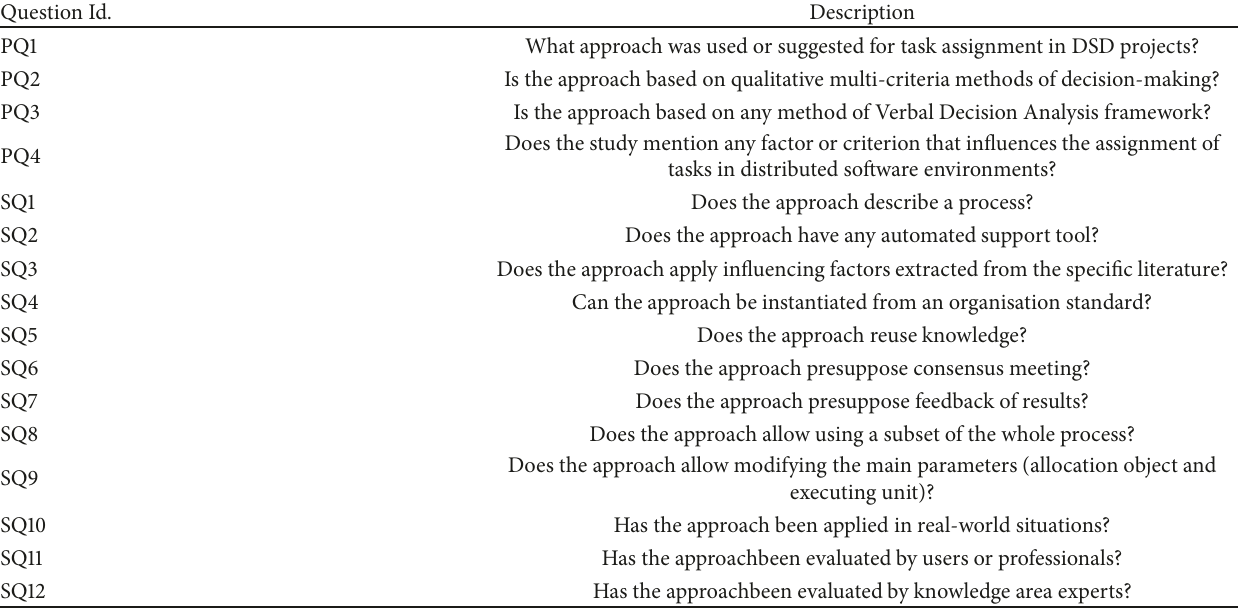
Table 1: Codes used in the data consolidation table.